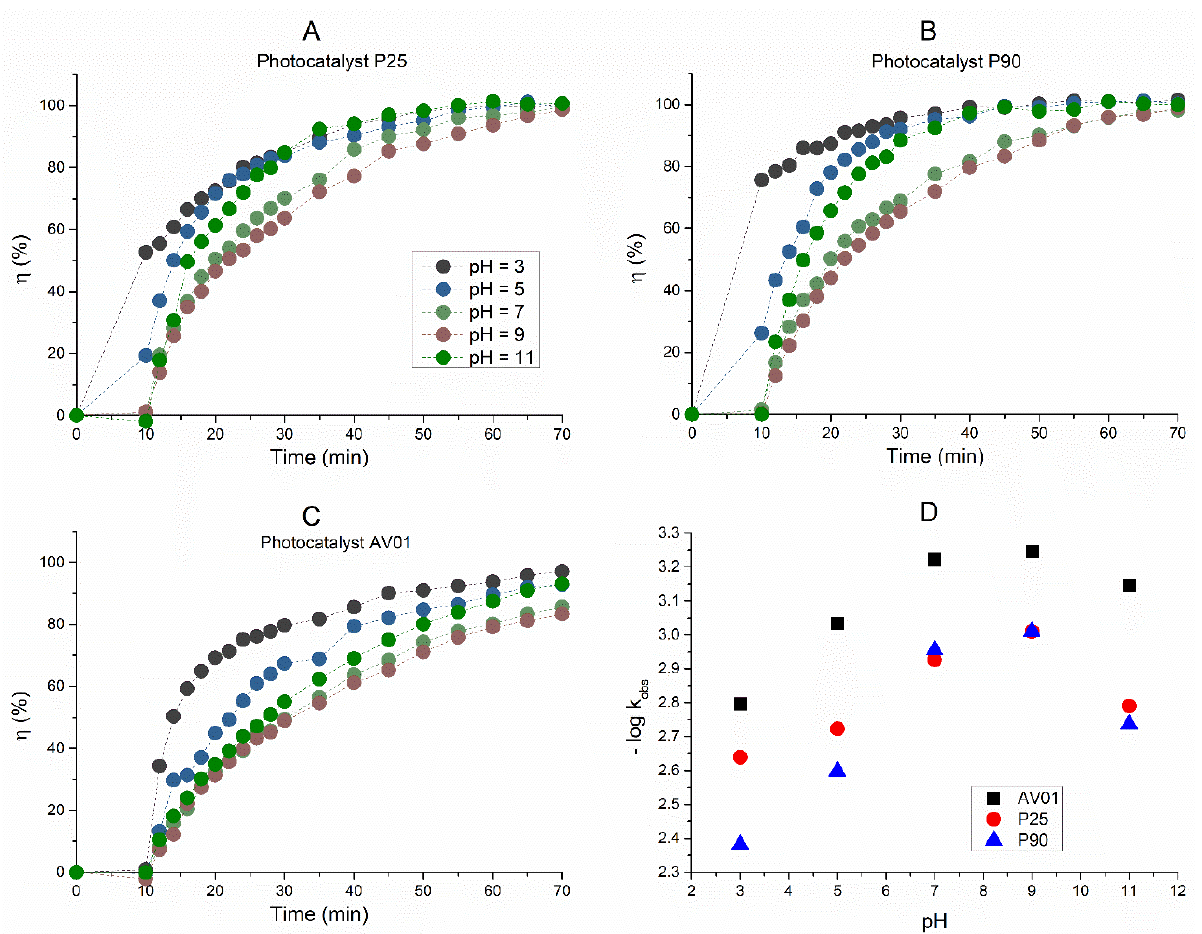
Figure 3. Dependence of the efficiency of decolorization of the model wastewater with Acid Blue 80 on the time of photocatalytic oxidation in the heterogeneous phase for photocatalysts ( A ) P25, ( B ) P90, and ( C ) AV01. ( D ) pH profiles of photocatalytic oxidation in the heterogeneous phase for photocatalysts P25, P90, and AV01. The initial concentration of AB80 was 1 × 10 − 4 mol/L. The spectrophotometric kinetic measurements were performed at t = 25 °C, λ anal = 627 nm, and at a pH ranging from 3 to 11.